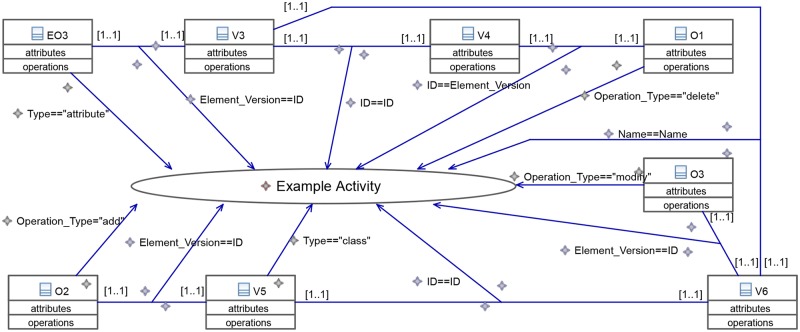
Example activity modeled in Strelka [23].